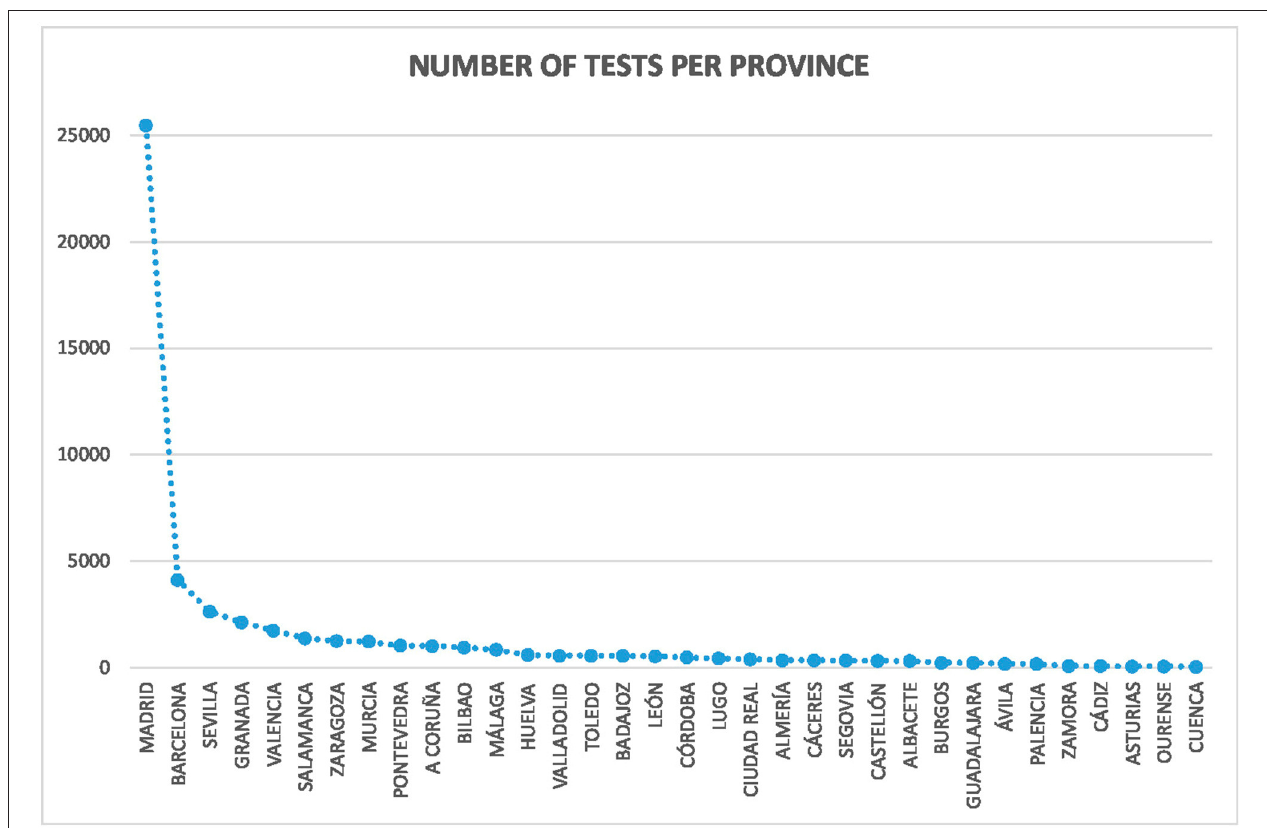
FIGURE 3 | Distributions of tests per province in Spain.